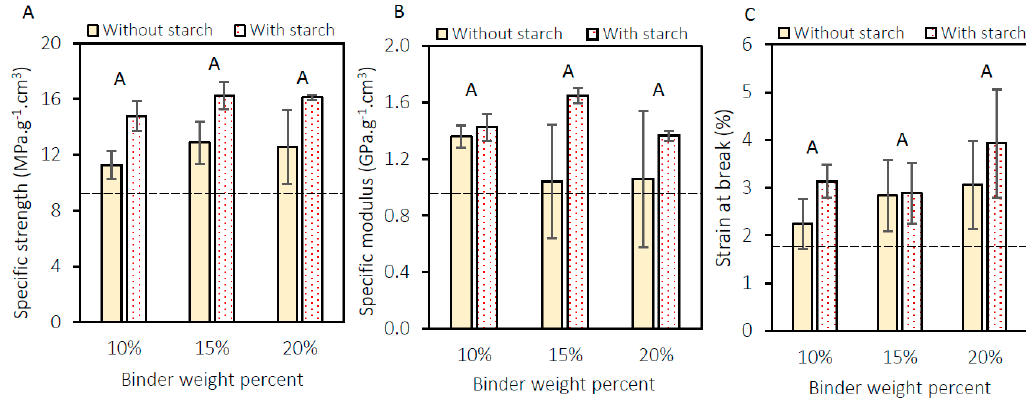
Figure 8. ( A ) Specific strength, ( B ) specific modulus and ( C ) strain at the break of panels with a density